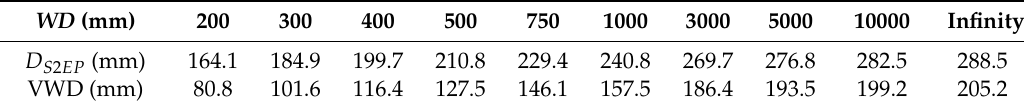
Table 5. Real object distance versus its virtual image underwater for the NiMAR NI320 dome